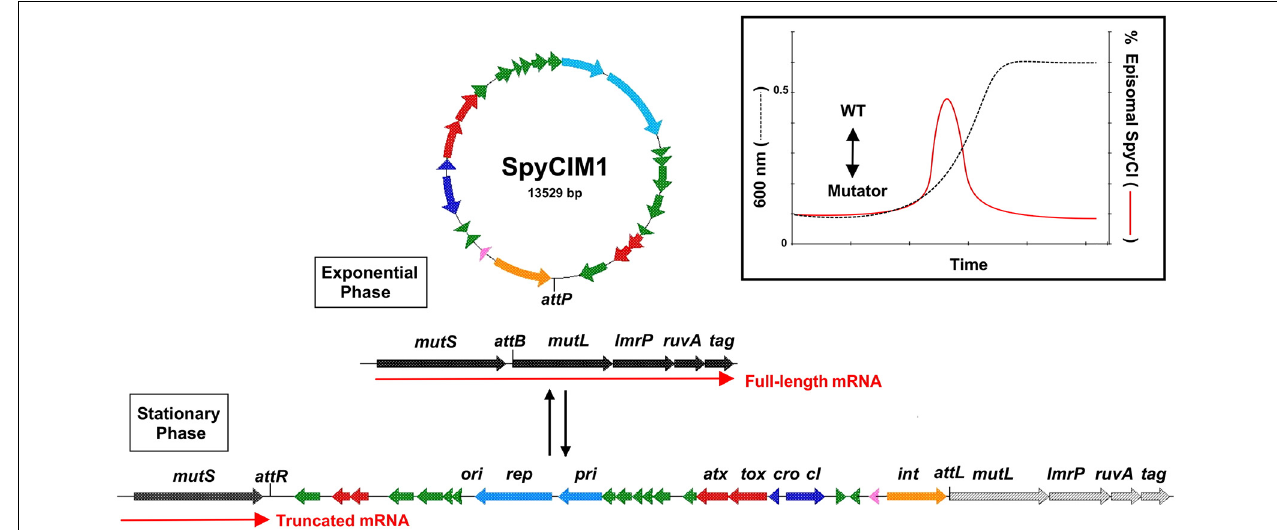
FIGURE 1 | SpyCIM1 regulates the MMR operon through dynamic site-specific excision and integration. The molecular switch controlled by SpyCIM1 is shown. The MMR operon of S. pyogenes is comprised of genes encoding DNA mismatch repair ( mutS and mutL ), multidrug efflux ( lmrP ), a Holliday-junction resolvase ( ruvA ), and base excision repair ( tag ). During exponential phase, SpyCIM1 excises from the chromosome, circularizes, and replicates as an episome, restoring transcription of the entire MMR operon (WT). Excision and mobilization occurs early in logarithmic growth in response to yet unknown cellular signals (Insert;